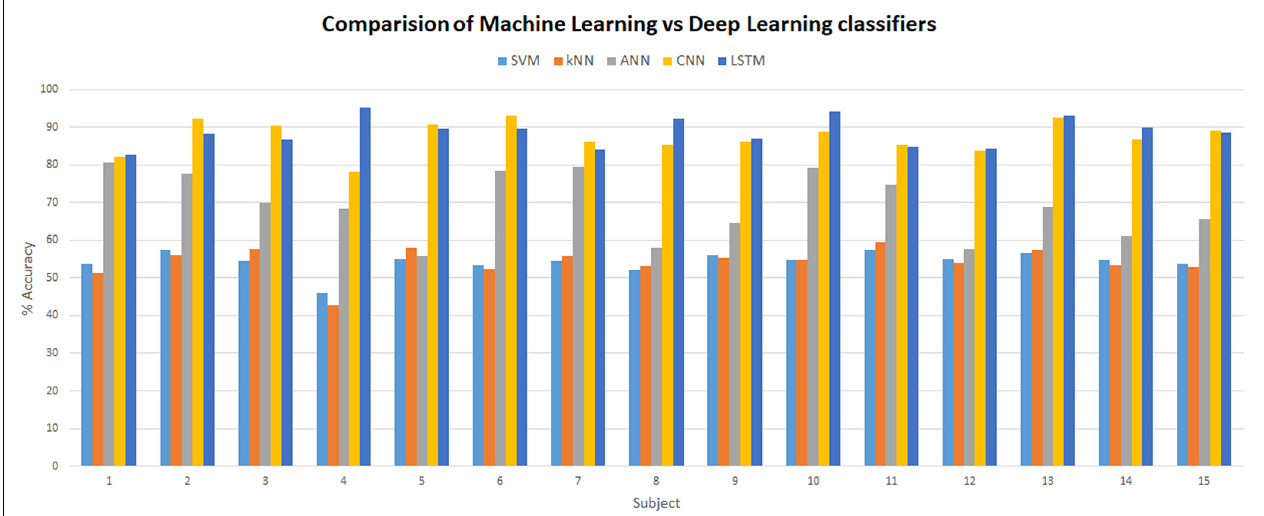
FIGURE 13 | Comparison between machine learning (SVM, k -NN, and ANN) and deep learning (CNN and LSTM) classifiers. SVM, support vector machine; k -NN, k -nearest neighbor; ANN, artificial neural network; CNN, convolutional neural network; LSTM, long short-term memory.